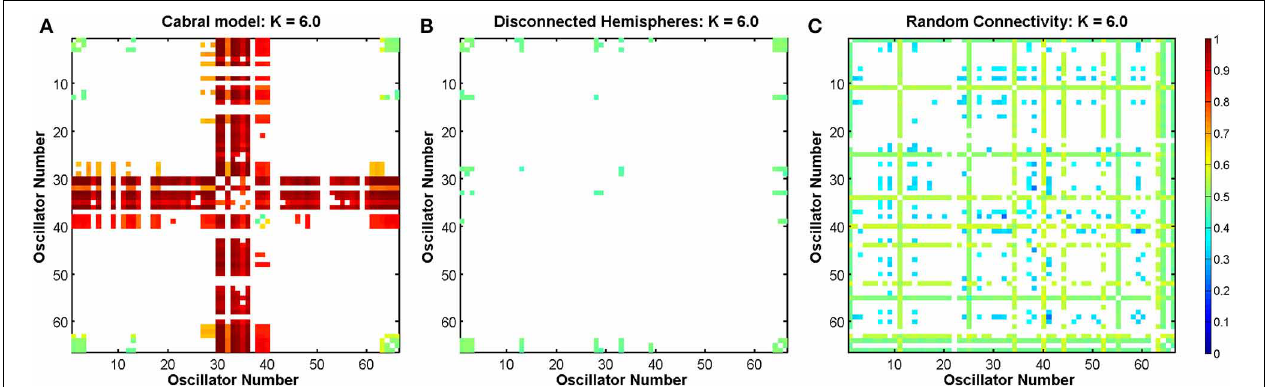
FIGURE 14 | DFA exponent of the rate of change of phase difference between all pairs of oscillators in the Cabral model at coupling K = 6 in three scenarios. (A) For the empirically observed connectivity matrix of the